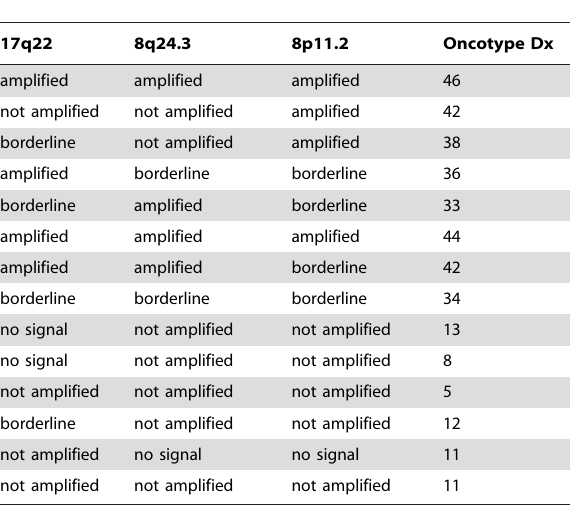
Table 3. Multivariate Cox analysis of Age, Tumor size, Tumor grade, Lymph node status, Progesteron status, Oncotype